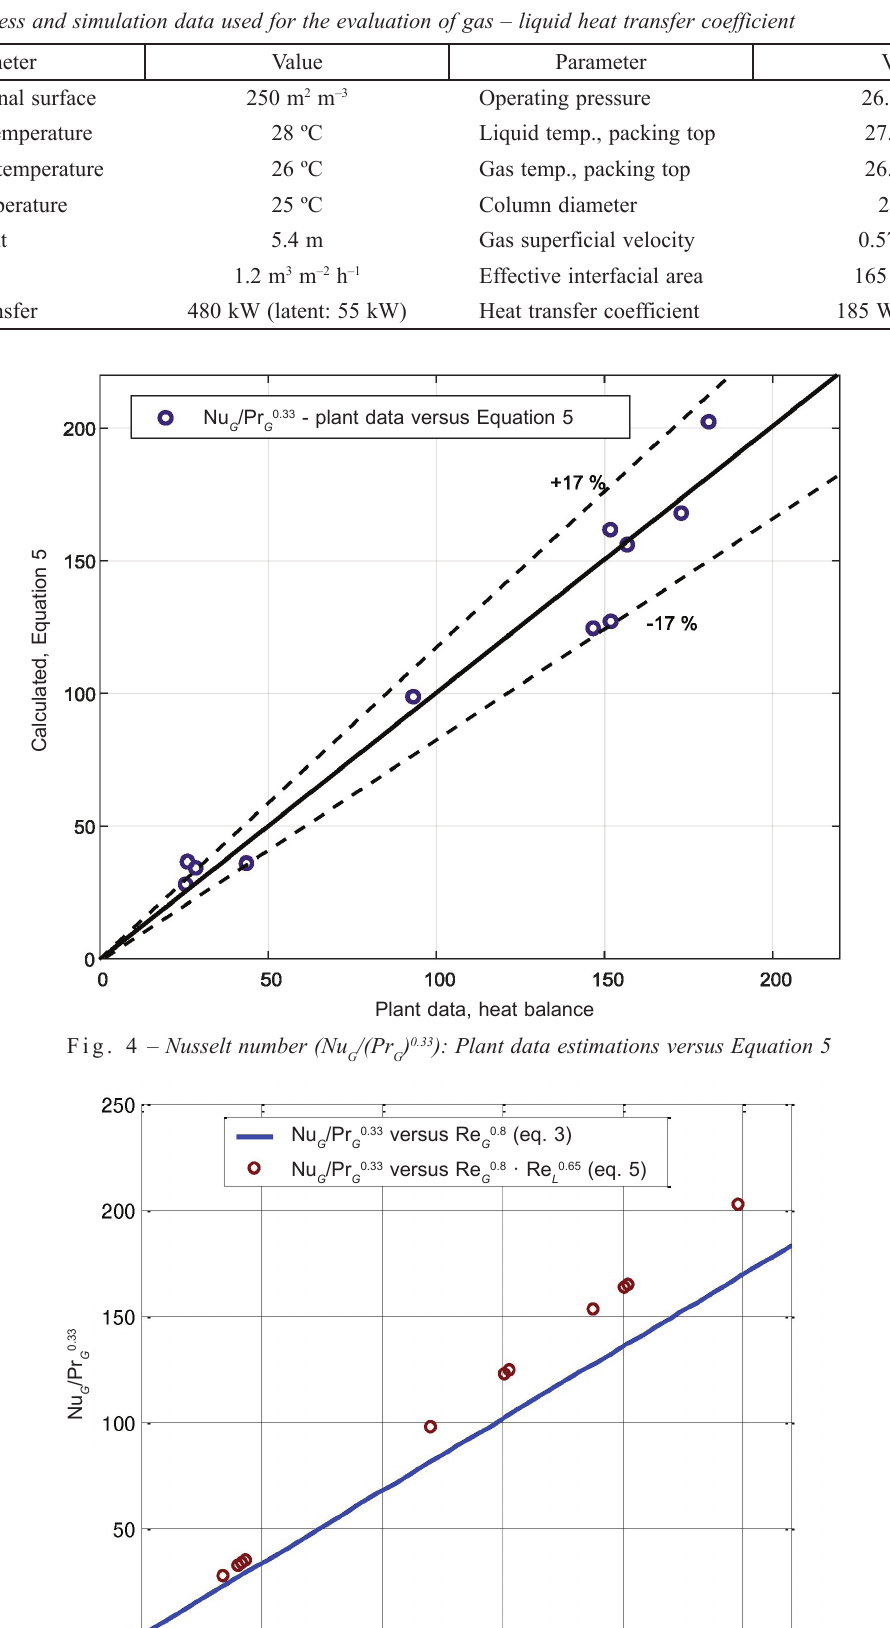
/(Pr ) 0.33 ) as calculated by Equations 3 and G G